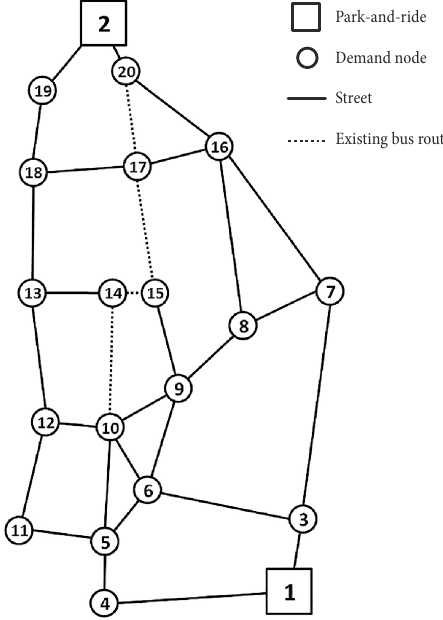
Fig. 7. Optimum urban bus routes through different